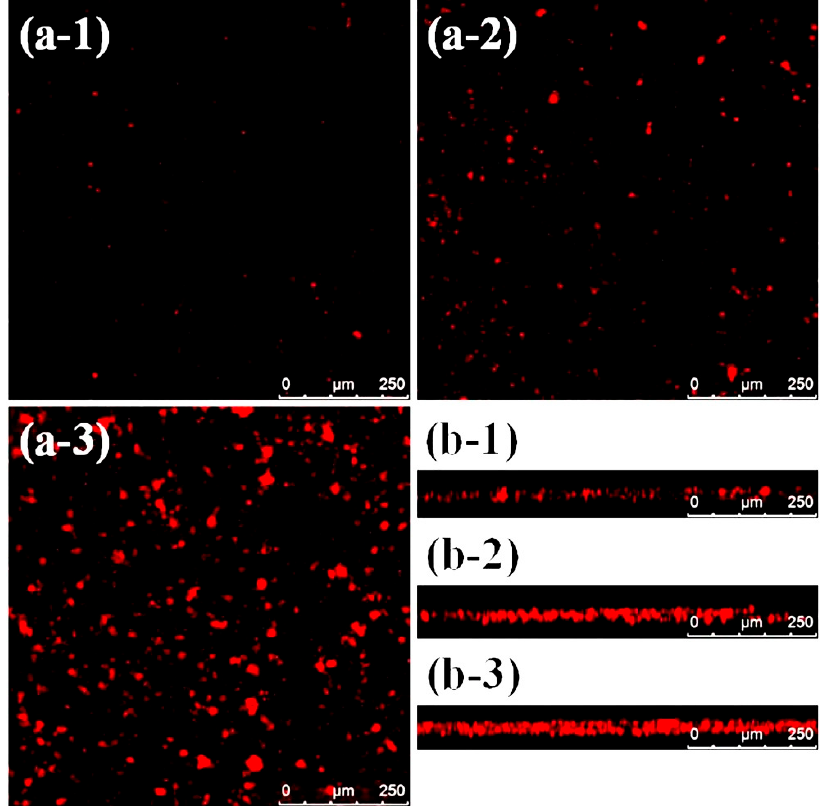
Figure 1. CLSM images of Bacillus sp. biofilm formed on the steel surfaces after ( a–1 ) 1 day, ( a–2 ) 1 week, and ( a–3 ) 1 month and side view images of biofilm that show biofilm thickness after ( b–1 ) 1 day, ( b–2 ) 1 week, and ( b–3 ) 1 month.